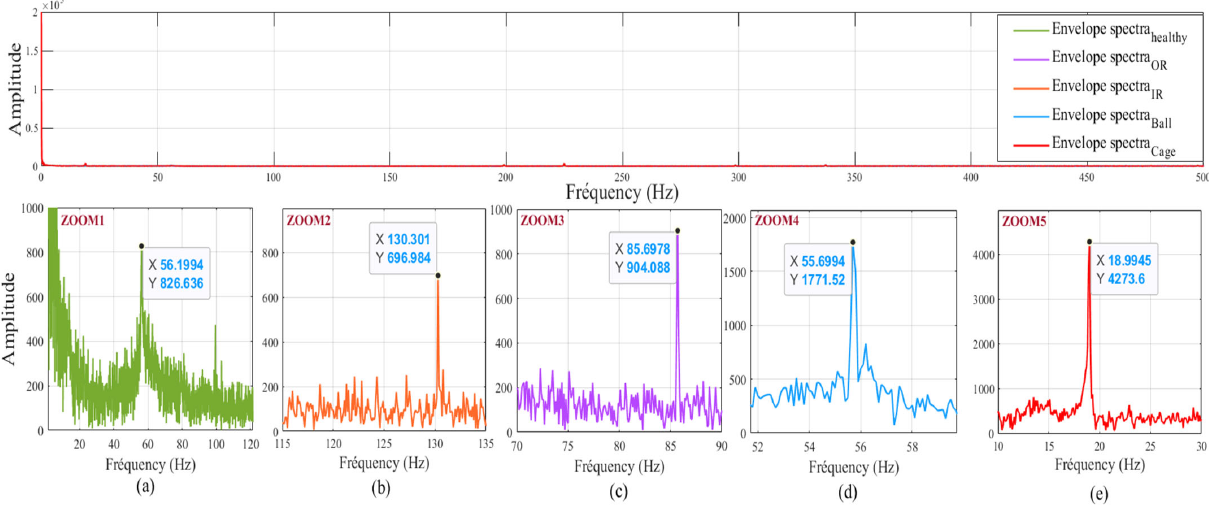
Figure 36. The envelope spectra of the IM current controlled by DTC, corresponding to the BD ( top ) case of the classic DTC command, Zoom showing each fault spectrum: ( a ) Healthy state, ( b ) IR defect, ( c ) OR defect, ( d ) Ball defect, ( e ) cage defect.